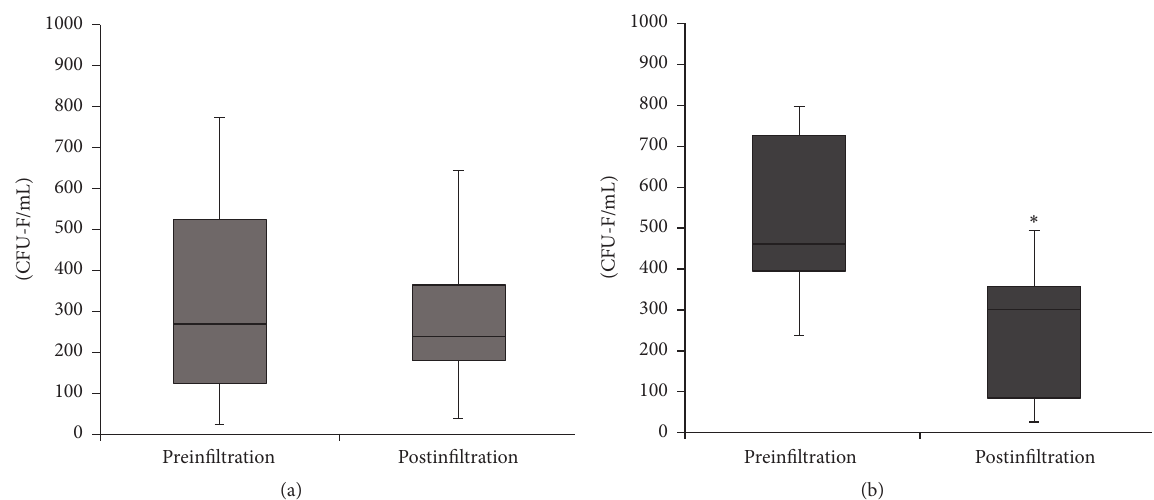
Figure 2: Colony-forming units fibroblast. Levels of colony-forming units fibroblast in the synovial fluids (CFU-F) before (preinfiltration) and one week after (postinfiltration) infiltration of Platelet Rich Plasm (PRP). (a) Intra-articular infiltration of PRP. (b) IO infiltration of PRP. ∗ 𝑝 < 0.05 .